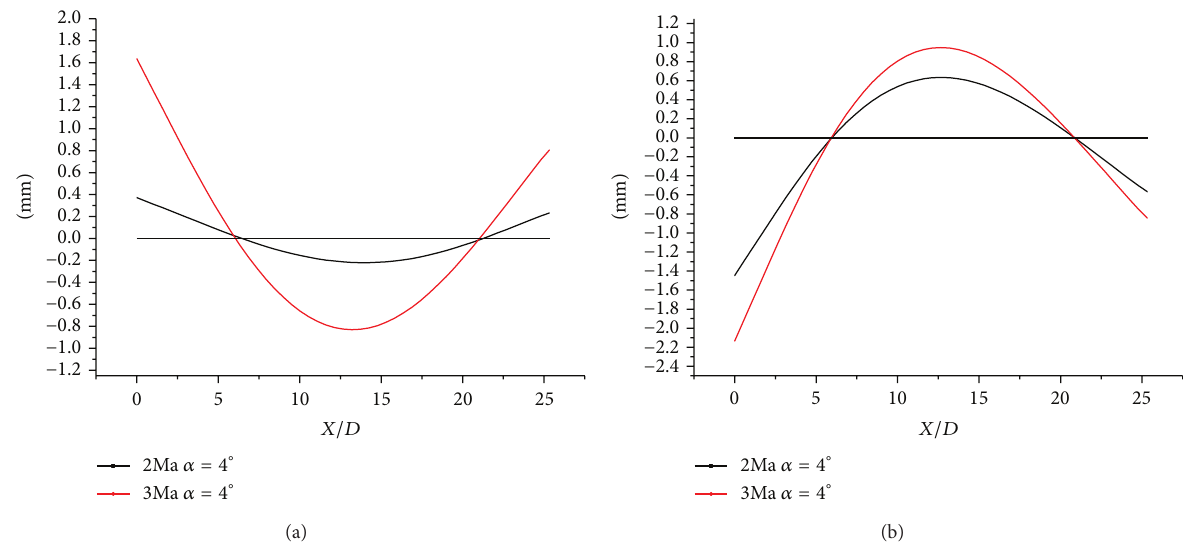
Figure 11: Deformations of spinning rocket body in: (a) 𝑌 -direction and (b) 𝑍 -direction.